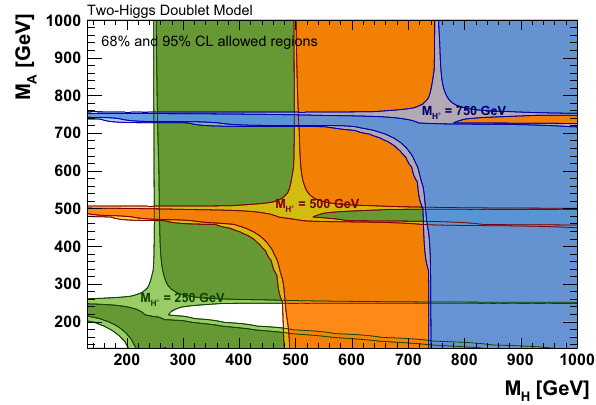
Fig. 11 2HDMfitresultsusingtheoblique S , T , U parameters.Shown are allowed 68 and 95% CL regions in the M A versus M H plane for fixed benchmark values of M H ± . The constraints are independent of